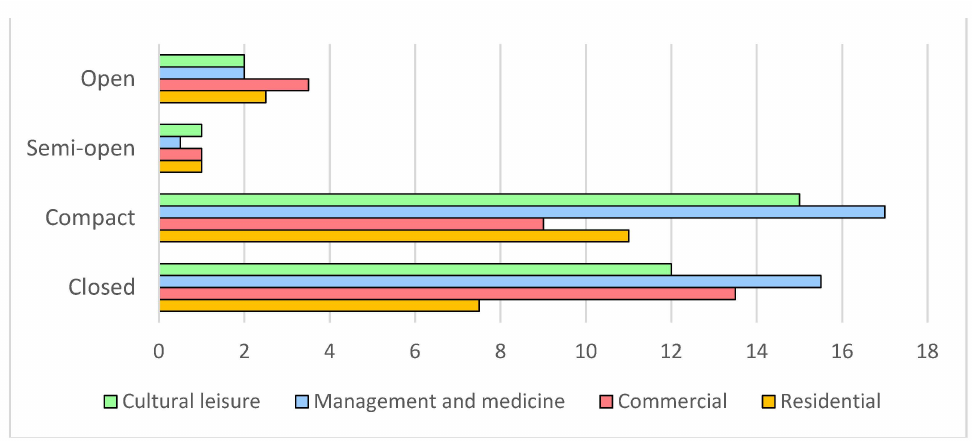
Figure 5. Layout of vitality types against street space